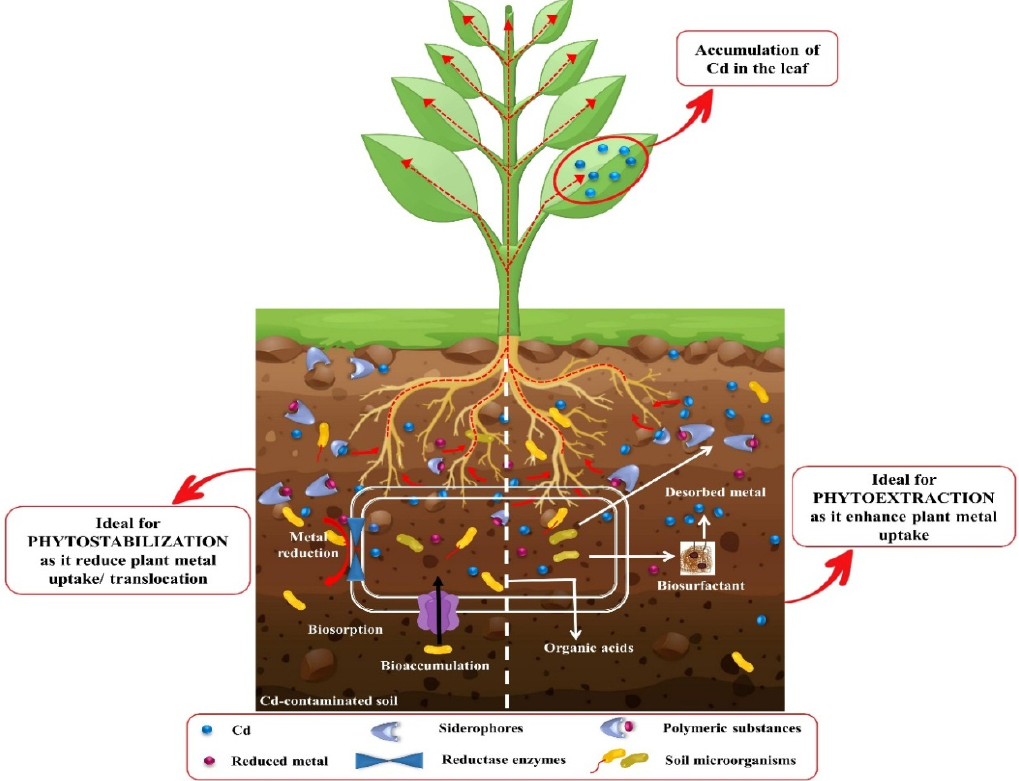
Figure 6. Schematic illustration of Cd phytoremediation by microbes. In the phytoextraction process, the production of siderophores and organic acids by the soil microbes influences the